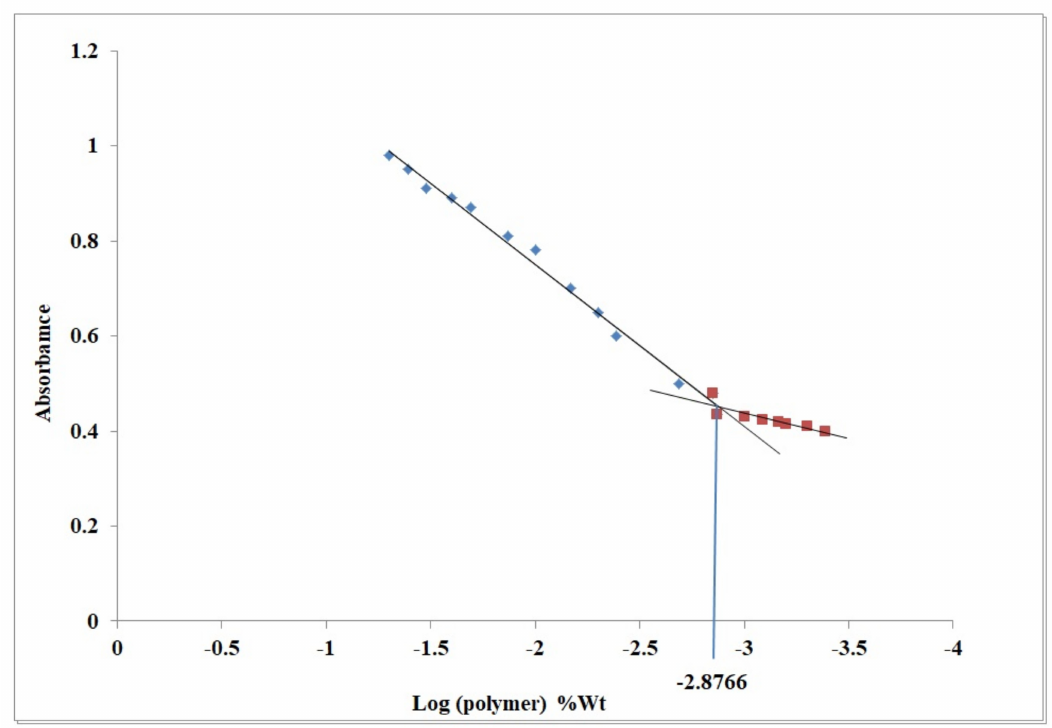
Figure 1. UV absorbance of I 2 versus P123/P407 at different concentrations in